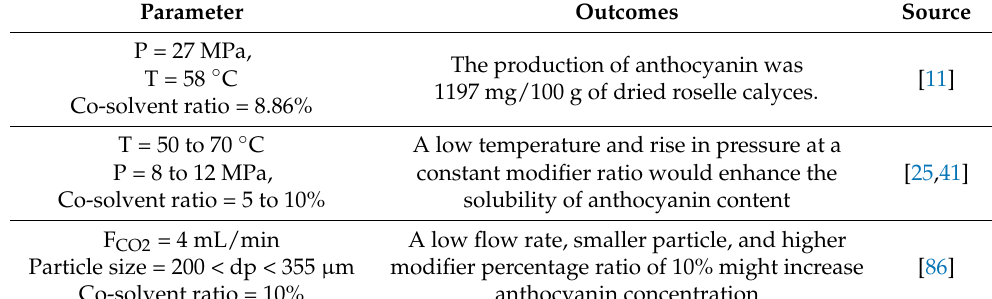
Table 5. Previous studies of anthocyanin recovery from roselle using ScCO 2 extraction. Parameter Outcomes Source P = 27 MPa, The production of anthocyanin was T = 58 ◦ C 1197 mg/100 g of dried roselle calyces. Co-solvent ratio = 8.86% A low temperature and rise in pressure at a T = 50 to 70 ◦ C constant modifier ratio would enhance the P = 8 to 12 MPa, solubility of anthocyanin content Co-solvent ratio = 5 to 10% A low flow rate, smaller particle, and higher F CO2 = 4 mL/min modifier percentage ratio of 10% might increase Particle size = 200 < dp < 355 µ m anthocyanin concentration Co-solvent ratio = 10% The optimal particle size, pressure, and temperature were determined to be 300 µ m, 27.5 MPa, and 50.8 ◦ C, respectively. The greatest Particle size = 212 < dp < 355 µ m extraction yield estimated with the optimized T = 40 to 80 ◦ C parameters was 163.26 mg/g. The most P = 20 to 30 MPa, significant factor in enhancing roselle extract is temperature due to the degradation of anthocyanins at high temperature The best conditions, as determined using response surface methodology, were 20 MPa, P = 10 to 20 MPa, 4.875 mL/min and 40 ◦ C producing 935.48 mg/L T = 40 to 60 ◦ C TPC, 14.11% red extract, and 816.16 mg/L TFC, F CO2 = 3 to 5 mL/min respectively. Pressure and temperature were significant factors to enhance the roselle extract with ScCO 2